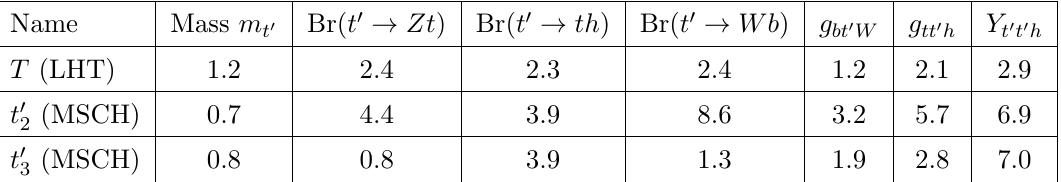
Table 3 . Estimated measurement precision, in %, of the relevant parameters in the LH and MSCH models at a 100 TeV pp collider with 30 ab (cid:0) 1 data set. All errors are statistical only. See text for